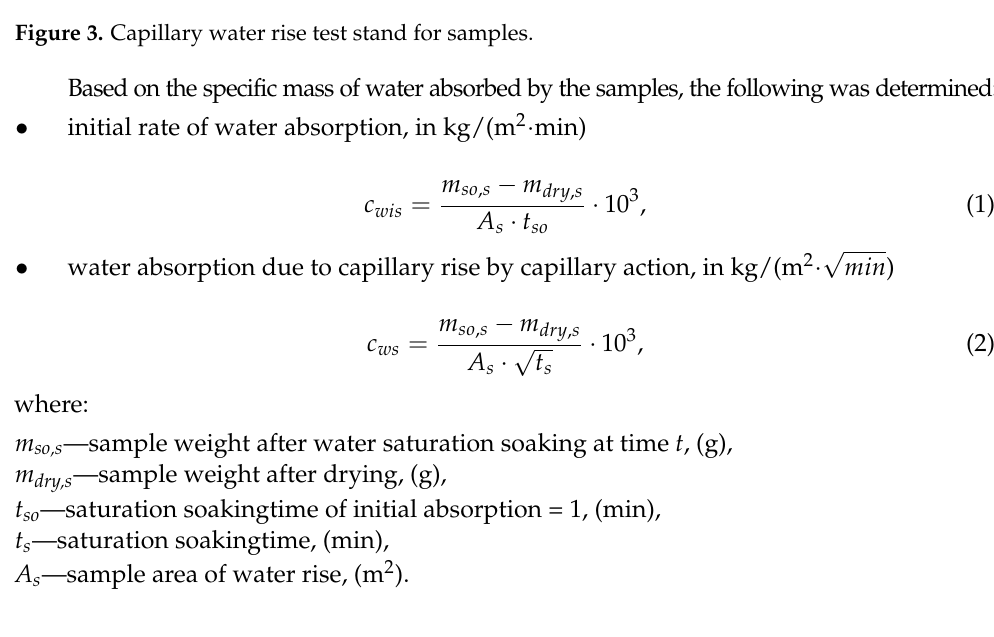
Figure 3. Capillary water rise test stand for samples.